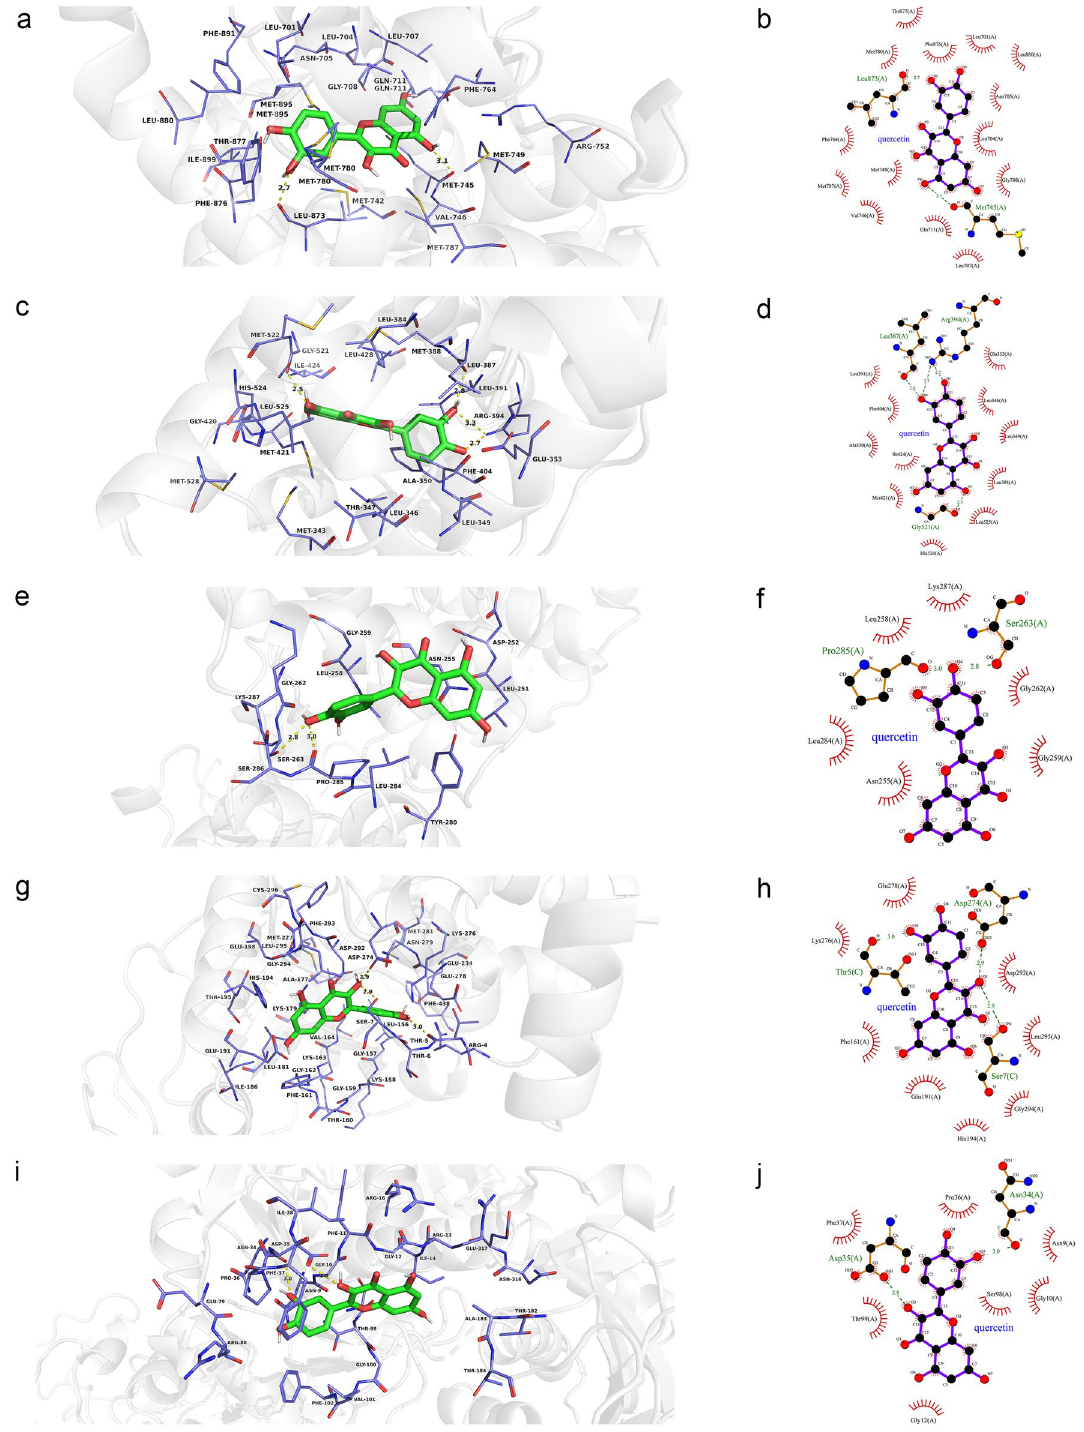
Figure 12. Molecular models of the binding of quercetin from LB to the predicted targets ( a , b ) AR, ( c , d ) ESR1, ( e , f ) MAPK3, ( g , h ) AKT1 and ( i , j ) GAPDH shown as 3D diagrams and 2D